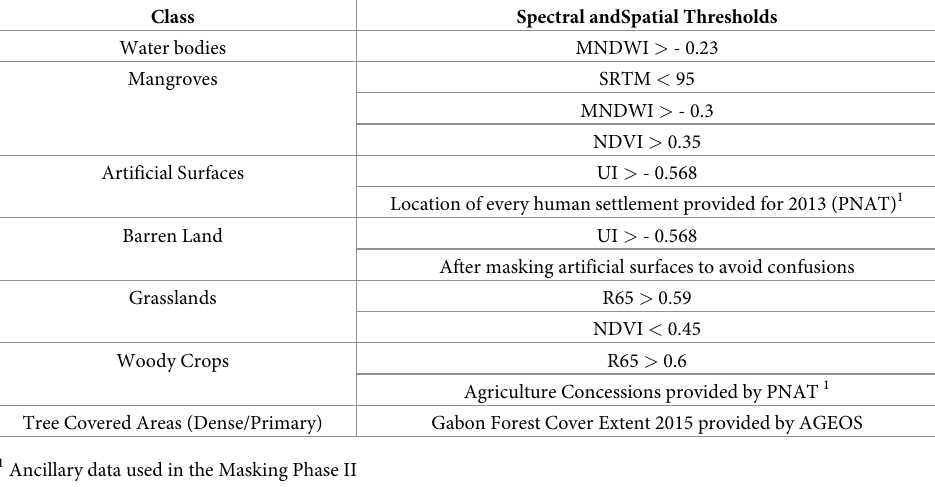
Table 5. Spectral and spatial thresholds for the pre-classification masking phase I and II for